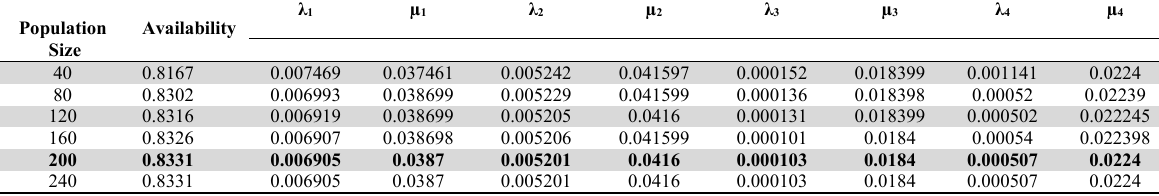
Fig. 5. Effect of Population Size on Fabric Finishing System Availability using GA Effect of Population Size on the Availability of FFS Using Genetic Algorithm λ 1 µ Population Availability